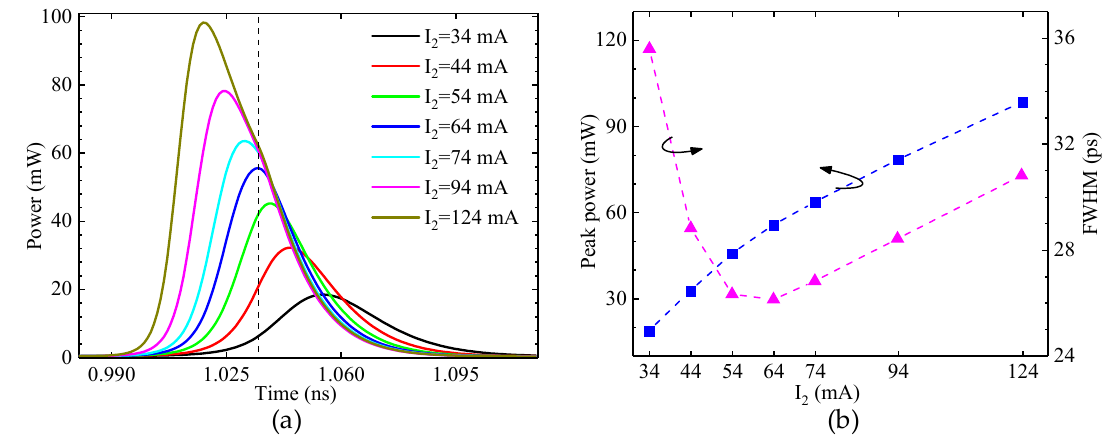
= 34 mA, T = 0.971 ns, I , when 34 I = mA, 0.971 T = ns, Figure 3. Simulation results of output pulses at different I 2 , when I 1 1 2 1 1